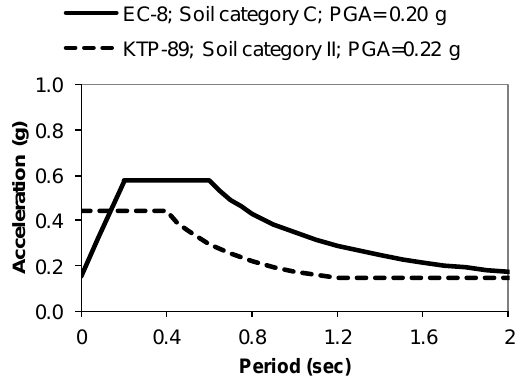
Fig. 6. Comparison of elastic response spectrums. Figure 6.Comparison of elastic response spectrums